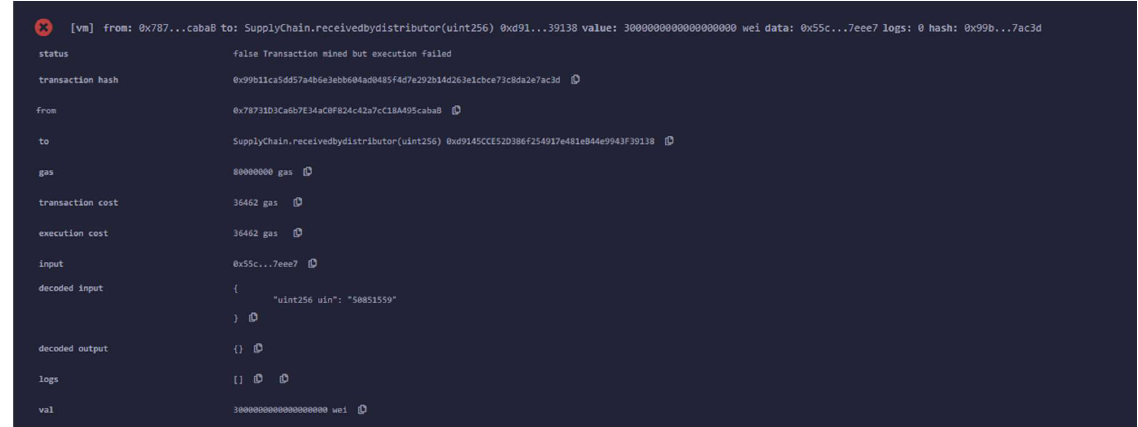
Fig. 9. Product on sale by manufacturer